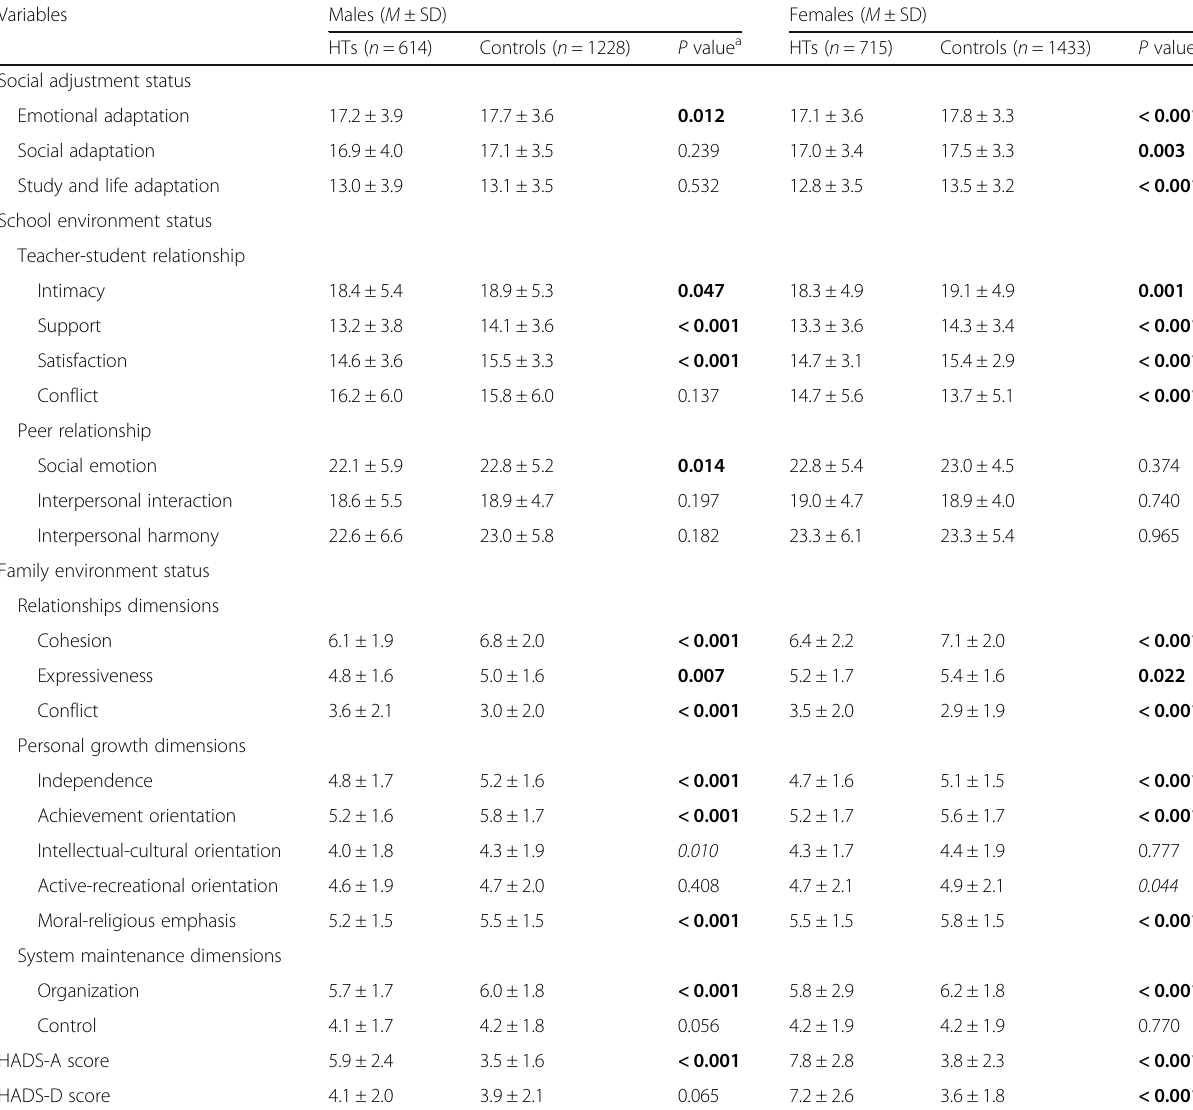
Table 3 Gender-specific for comparison of environmental factors between HTs and controls ( N = 3990)